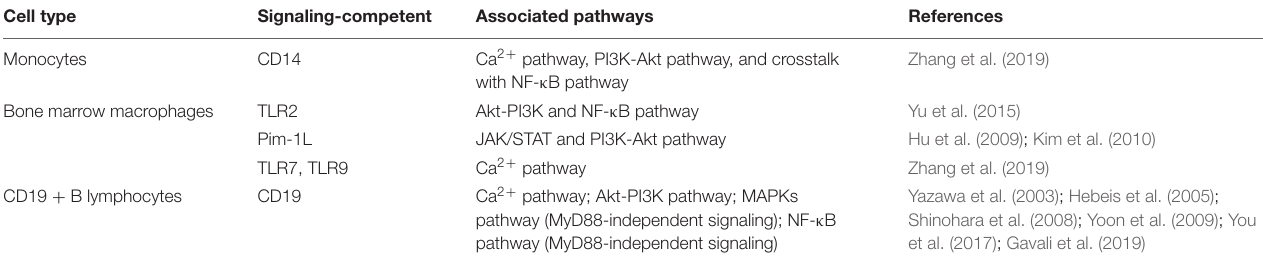
TABLE 1 | Potential “signaling-competent” partners of RP105/MD-1 during